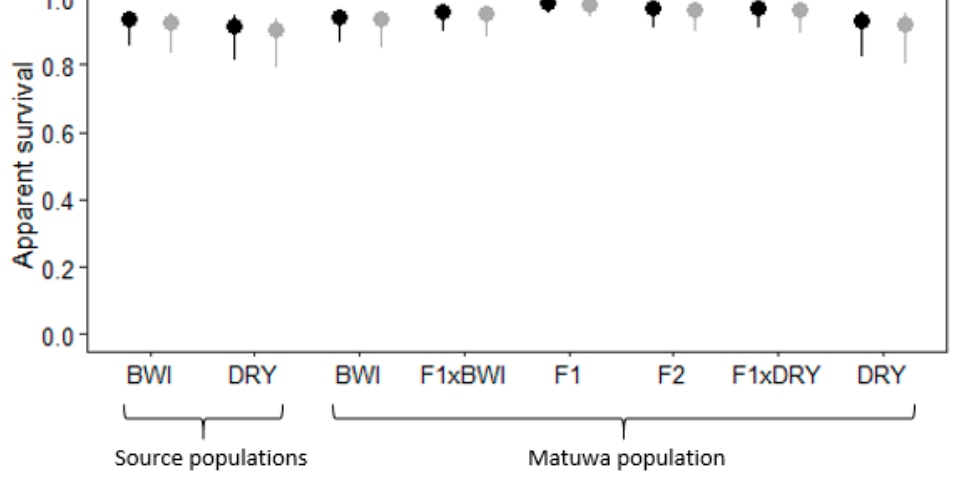
Figure 4. Average apparent survival with 95% confidence intervals for female ( ) and male ( ) Bettongia lesueur individuals from founder populations; Barrow Island and Dryandra and each hybrid class of the translocated population; pure-bred Barrow Island (BWI), pure-bred Dryandra (DRY), backcross to Barrow Island (F 1 × BWI), F 1 hybrid (F 1 ), F 2 hybrid (F 2 ), backcross to Dryandra (F 1 × DRY) and pure-bred Dryandra (DRY).